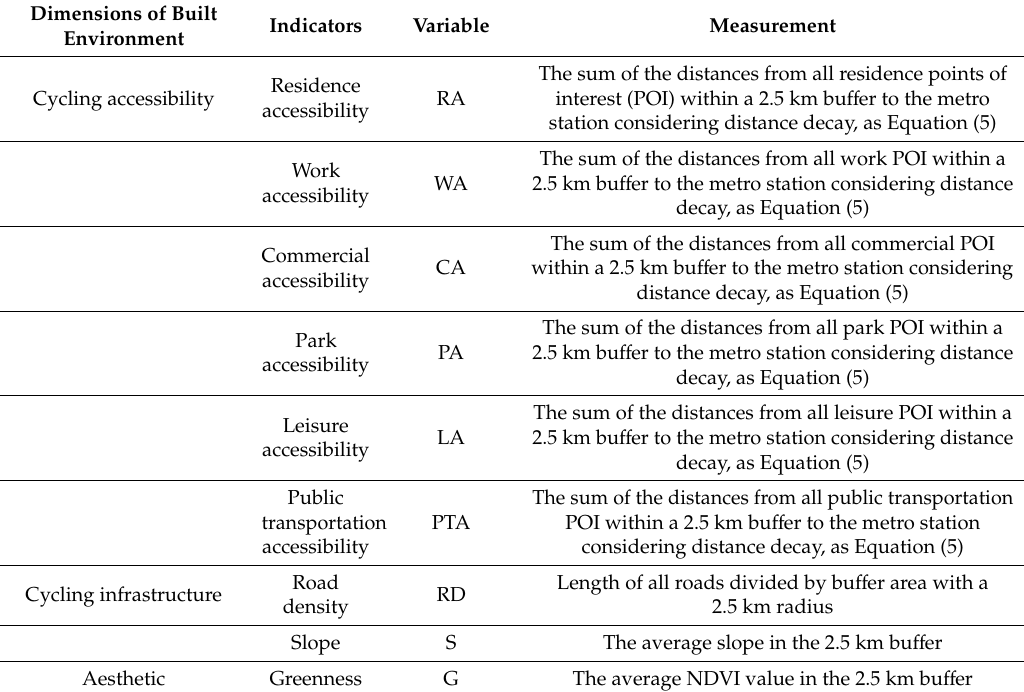
Figure 4. The research framework. Table 1. Independent